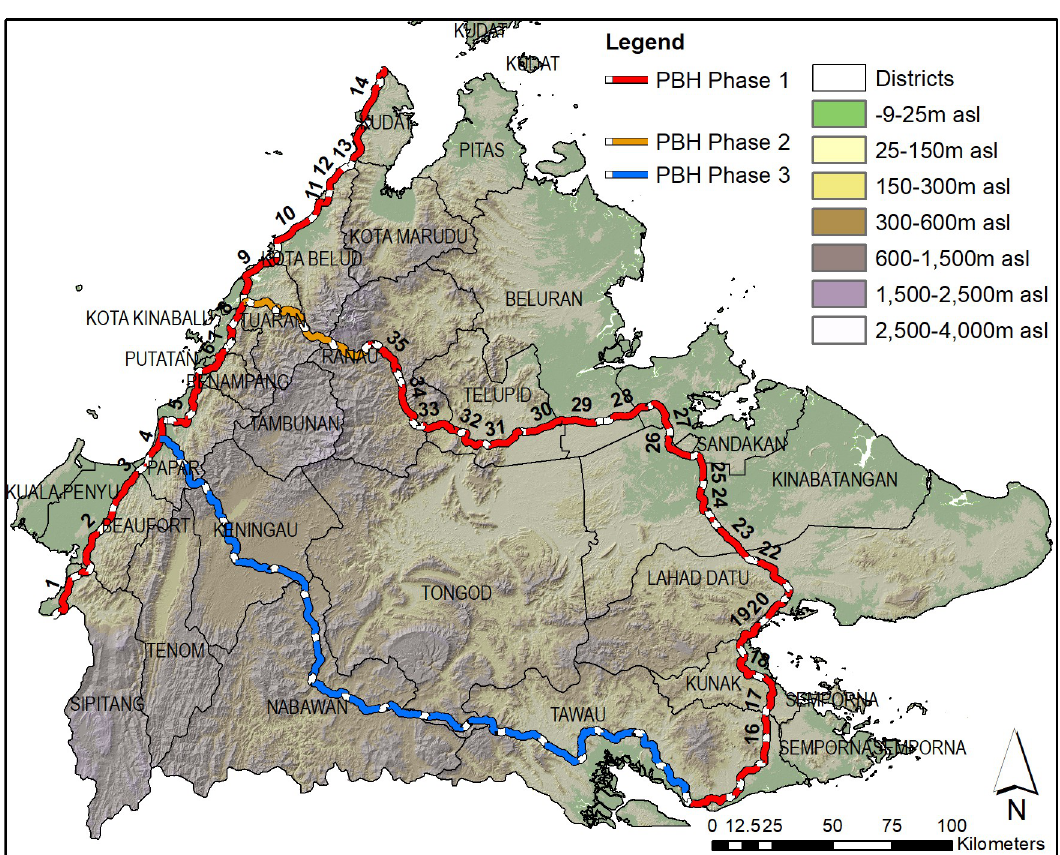
Fig 1. Pan Borneo Highway alignment. Alignment of the three phases of the Pan Borneo Highway (PBH) in Sabah. Phase 1 shown in red with work package numbers marked for the differing sections, as well as Phase 2 (in yellow), Phase 3 (in blue), and district boundaries and names, and elevation (in meters above sea level). Note, the alignments may change, dependent upon government